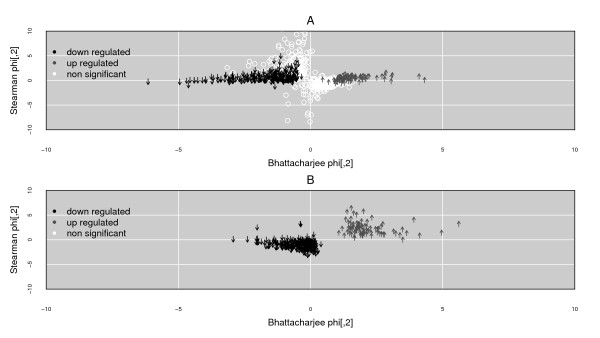
Cross-dataset Latent ProbeSet Structure. Cross-dataset Latent ProbeSet Structure using BaFL produced values. Two-dimensional projection calculated with spectral method of Higgs et al., as derived from the LaFon method. Sample correlation values using differential expression (DE) gene responses were used as input. Each symbol represents a ProbeSet, both color and direction of arrow indicate change: up (gray)- or down (black)-regulation, or not significantly different (white). Panel A: the 940 ProbeSets that are DE in both experiments. These ProbeSets pass BaFL pipeline criteria and are categorized as DE according to both RMA and dCHIP output (but not always in the same direction). Dark Grey upward-pointing arrows indicate up-regulated genes in the adenocarcinoma samples relative to normal samples. Black downward-pointing arrows indicate down regulation in adenocarcinoma samples relative to normal samples. Open white circles in Panel A indicate ProbeSets that BaFL does not interpret as significantly differentially expressed, while the other methods do. Bottom graph: the subset from panel A of the 325 ProbeSets predicted to be significantly DE by BaFl. The tables from which the graphs are made are provided in the Supplementary Materials Web site for the article, Latent Structure [19].